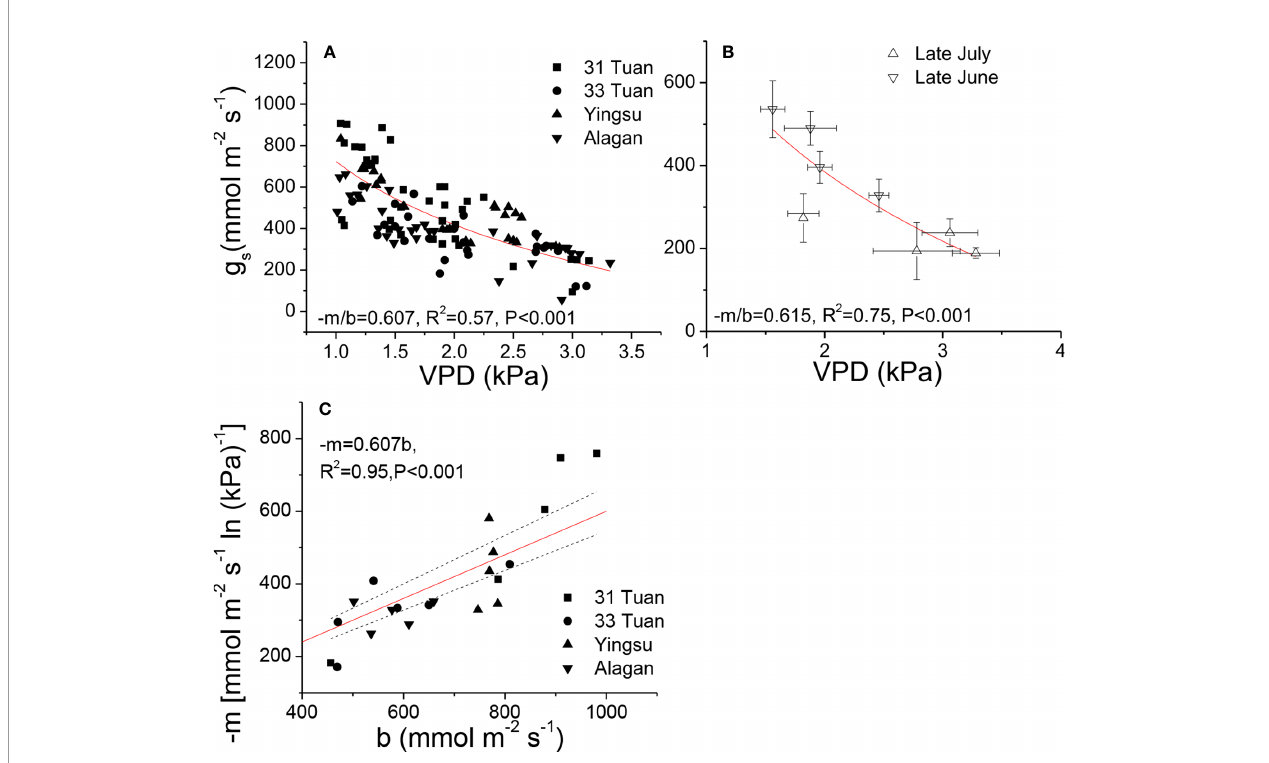
FIGURE 2 | Relationships between g s and VPD (A, B) , and the relationship between − m and b (C) of Populus euphratica among the four sites. The measurements were taken by manipulating VPD in late June (A, C) , and natural VPD in late June and late July (B) . The curves were generated by using the hydraulic model (Equation 1). In (C) , red line represents the theoretical line of the expected relationship ( − m = 0.6 b ), black dash lines represent 95% con fi dence intervals of linear regression between observed − m and b